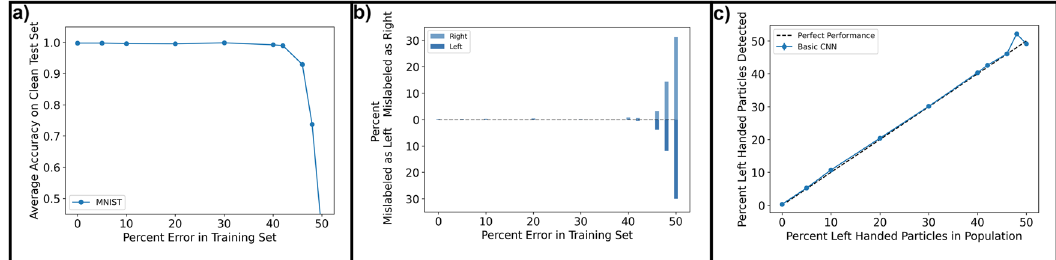
Fig. 3 Figures quantifying the performance of the standard CNN on the MNIST training sets. a Accuracy of standard CNN on the MNIST seven error-free ground truth test set given increasing error in the training set. b The percent of sevens erroneously labeled as left or right handed in the test set. c Percent of left-handed sevens in a population predicted by a network that was trained with data containing that percent of lefts. Error bars are obtained by training each architecture multiple times and then calculating the standard error on the accuracy of the test set by the multiple versions of the network.